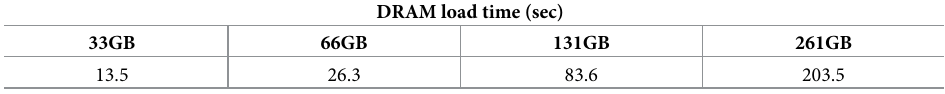
Table 2. The time (in seconds) to copy data from NVMe SSD to DRAM as a function of DRAM